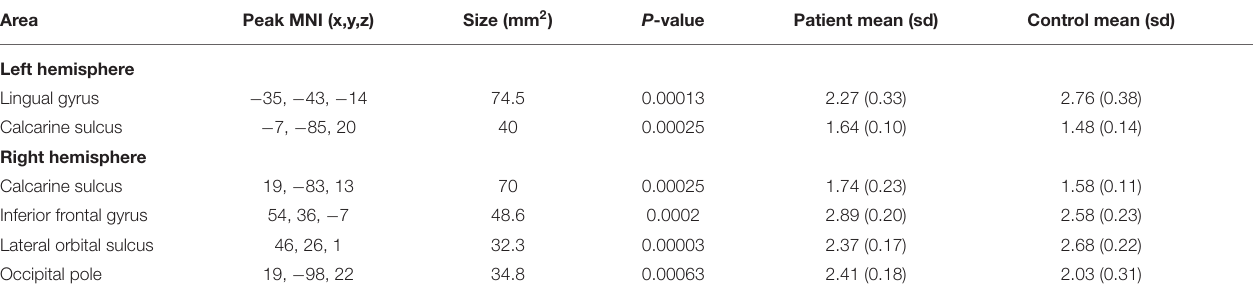
TABLE 1 | Areas differing in cortical thickness between patients and